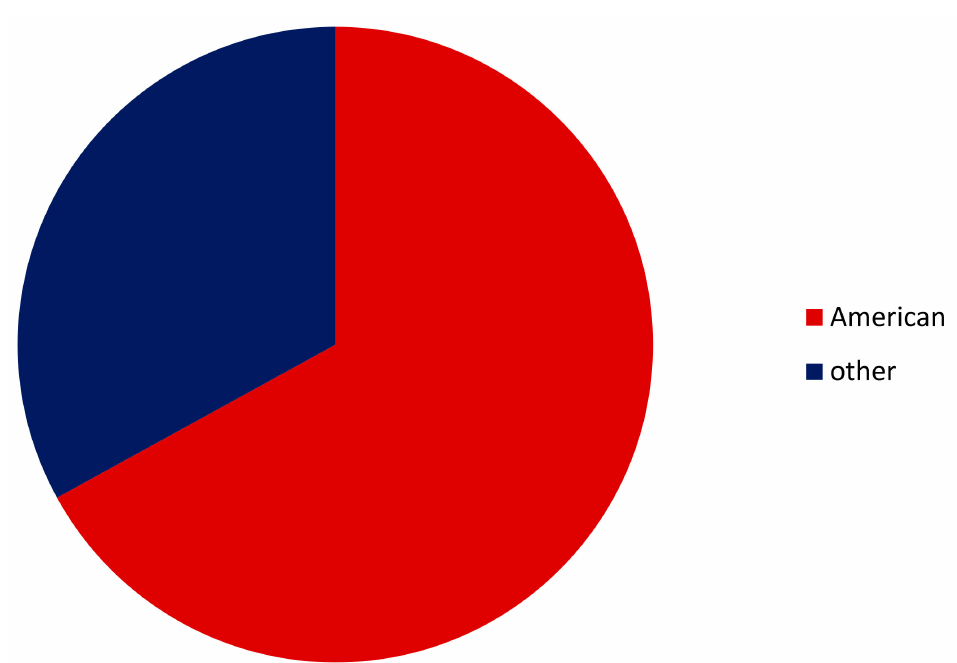
Figure 1. Proportion of American versus crayfish coming from other geographical origins, based on GRIIS [11]. Table 1. Alien crayfish species based on GRIIS (Global Register of Introduced and Invasive Species) [11]. Distribution in freshwater and/or saline habitats determined due to CABI (Centre for Agriculture and Bioscience International), GBIF (Global Biodiversity Information Facility), GRIIS and NEMESIS (Smithsonian Environmental Research Center’s National Estuarine and Marine Exotic Species Information System) databases